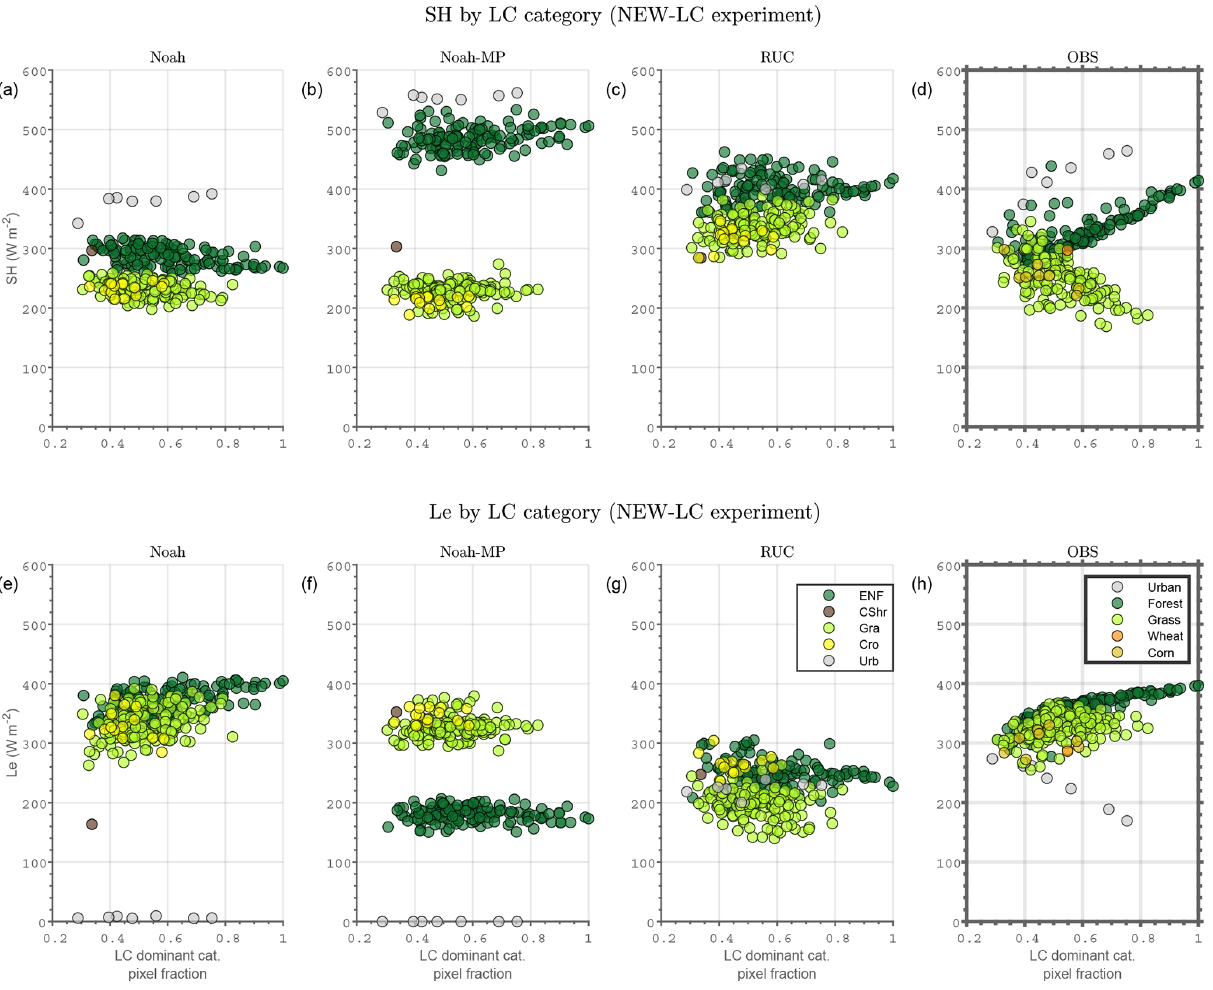
Figure 6. SH (a–d) and Le (e–h) simulated at 12:00UTC by each LSM: Noah (a, e) , Noah-MP (b, f) , and RUC (c, g) . The x axis shows the total fraction covered by the dominant LC category in each respective pixel. The results are provided for the different LC categories with colours. Panels (d) and (h) represent the same but for the gridded area-averaged fluxes (AAFs) calculated from the EC measurements, which are used for the model